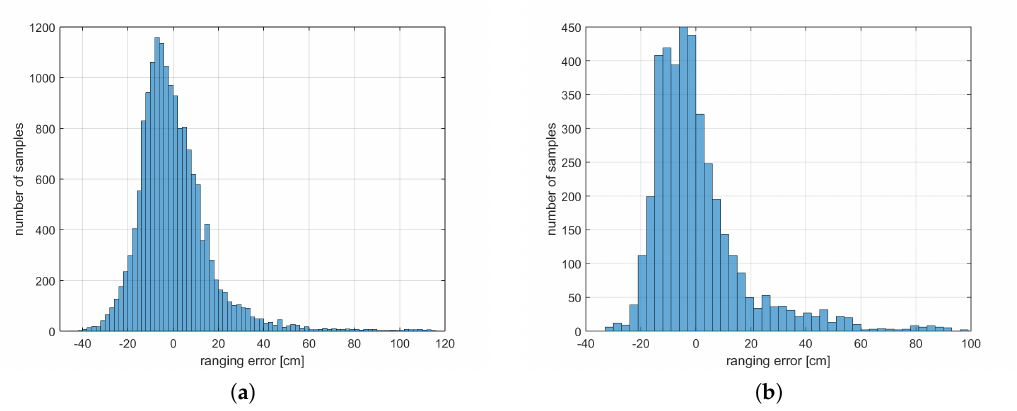
Figure 2. Histogram of UWB ranging error: ( a ) errors from all devices; ( b ) errors from just one